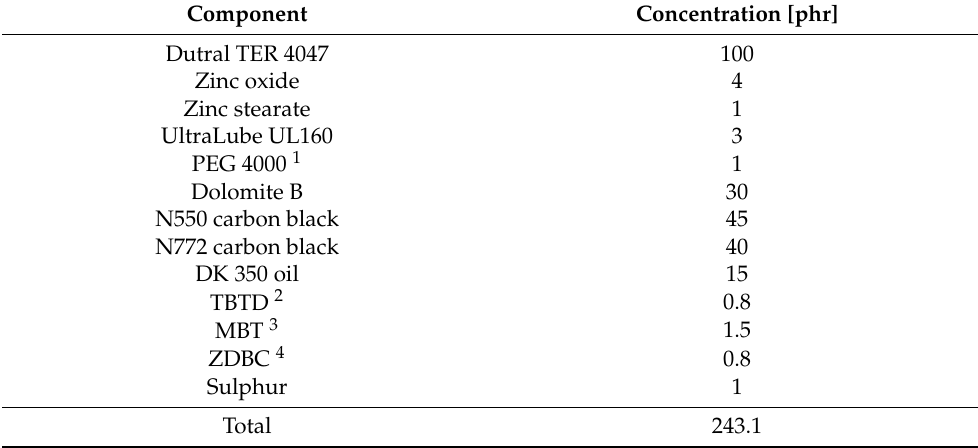
Table 1. Composition of the EPDM rubber mixture used for the devulcanisation experiments. Component Concentration